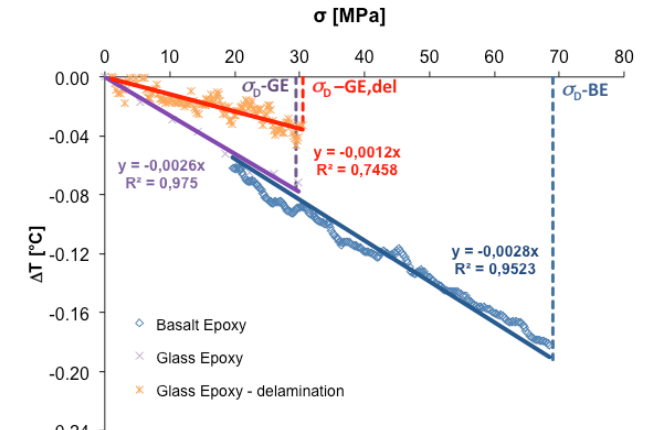
Figure 6: Temperature vs Stress for fibre reinforced composites: glass/epoxy, glass/epoxy with induced delamination, and basalt/epoxy. In this graph, only the data related to the linear temperature region (region I) are reported, along with the corresponding regression line. On the abscissa, the damage stresses of each tested material (  induced delamination, and  -BE for basalt/epoxy) are D